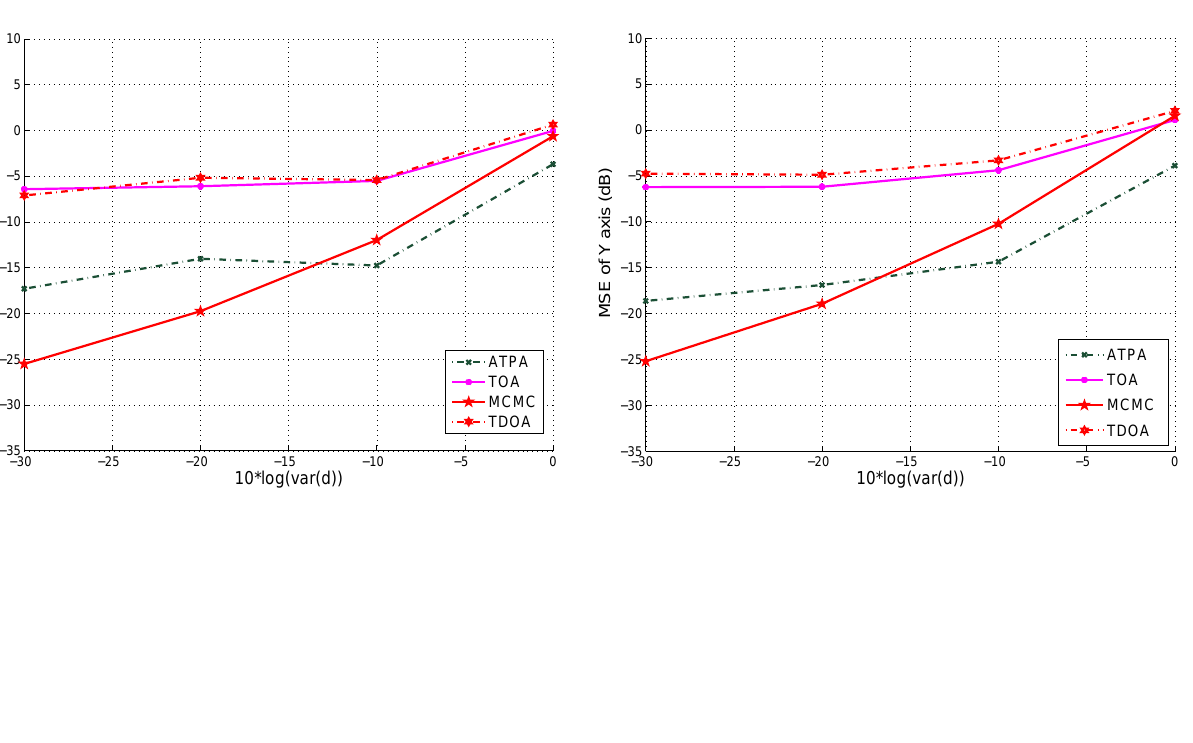
Figure 18. The effect of mobility on position estimation (using TOA information); position error of the x-coordinate (left) and position error of the y-coordinate